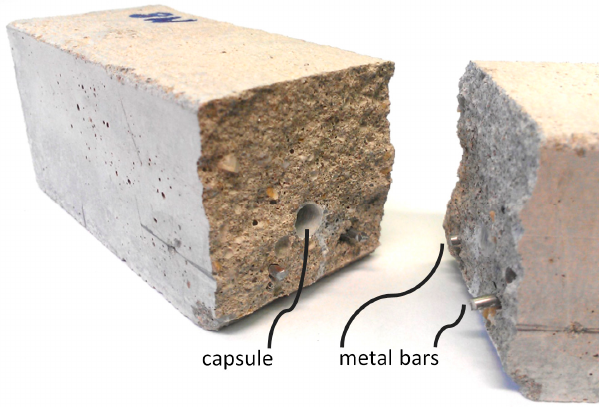
Figure 2. Split 4 cm × 4 cm × 16 cm specimen showing an embedded capsule that has been ruptured during bending.